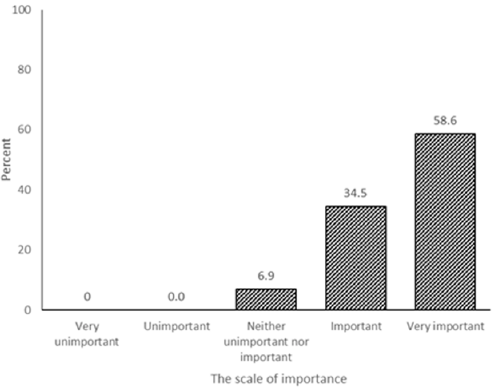
Figure 1. The importance of the integration of scientific knowledge in ex situ species management into the species’ conservation policy and practice.